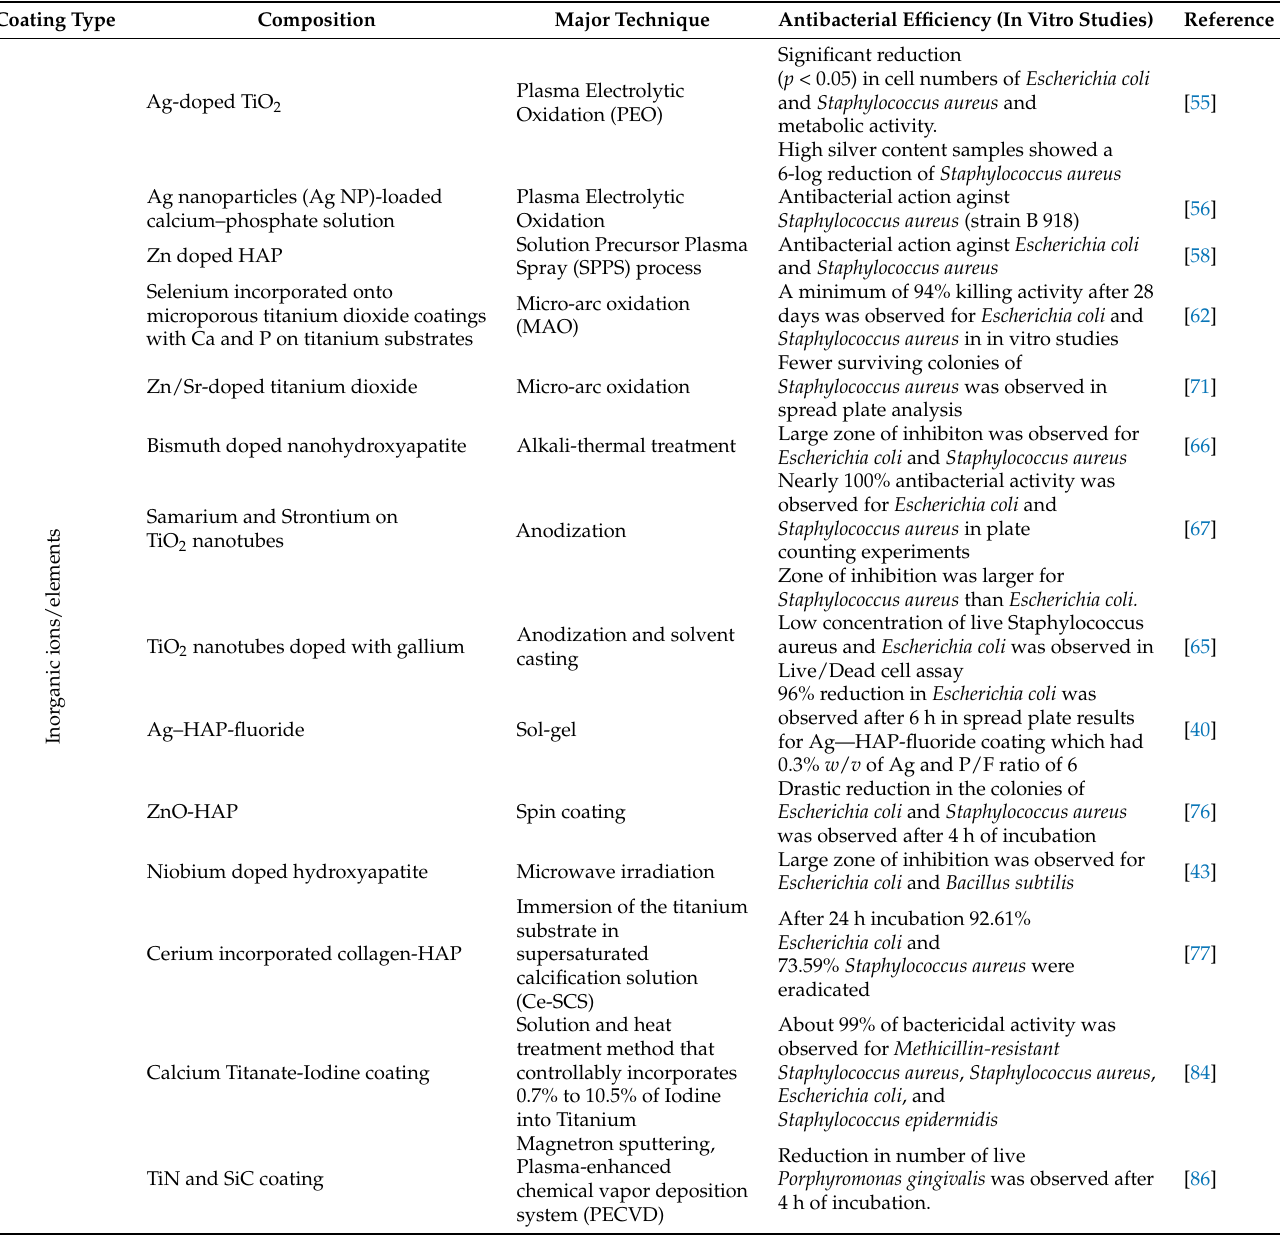
Table 1. Different types of titanium implant coatings and their antibacterial